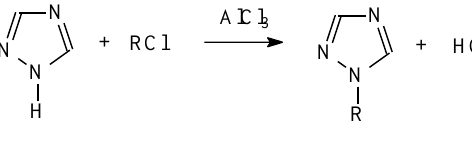
Table 1. Properties of